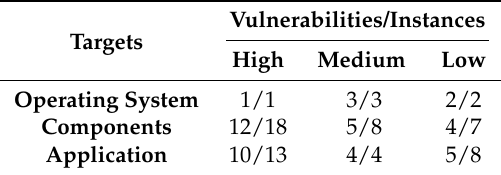
Table 3. Results: Second